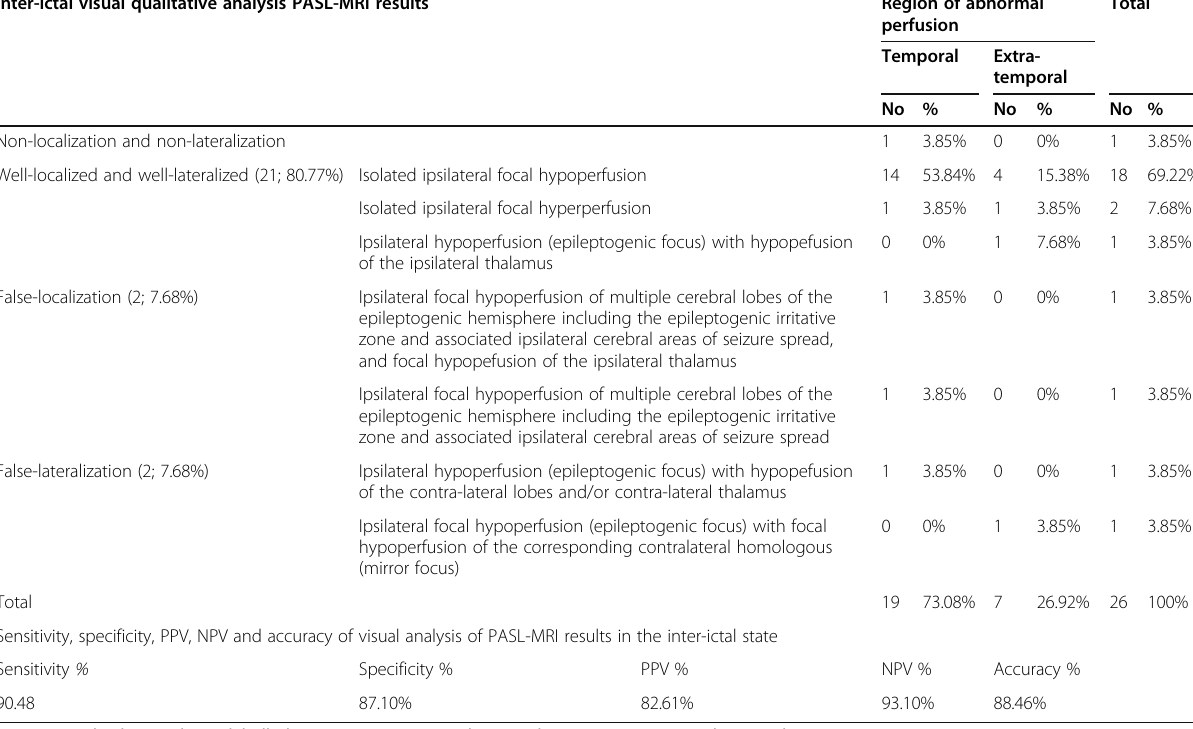
Table 3 Diagnostic performance of qualitative (visual) data of ASL-MRI of both cerebral hemispheres ( n = 52) of the studied patients ( n = 26) Inter-ictal visual qualitative analysis PASL-MRI results Region of abnormal Non-localization and non-lateralization 1 Well-localized and well-lateralized (21; 80.77%) Isolated ipsilateral focal hypoperfusion